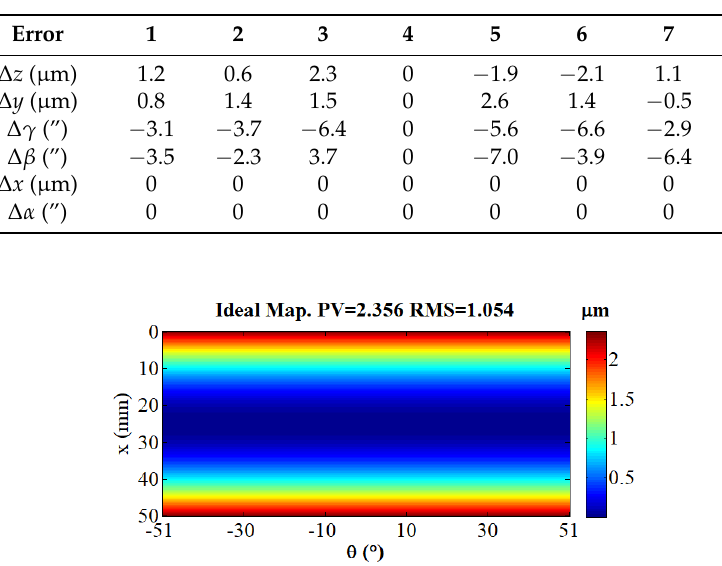
Table 1. Errors of the sub-apertures.